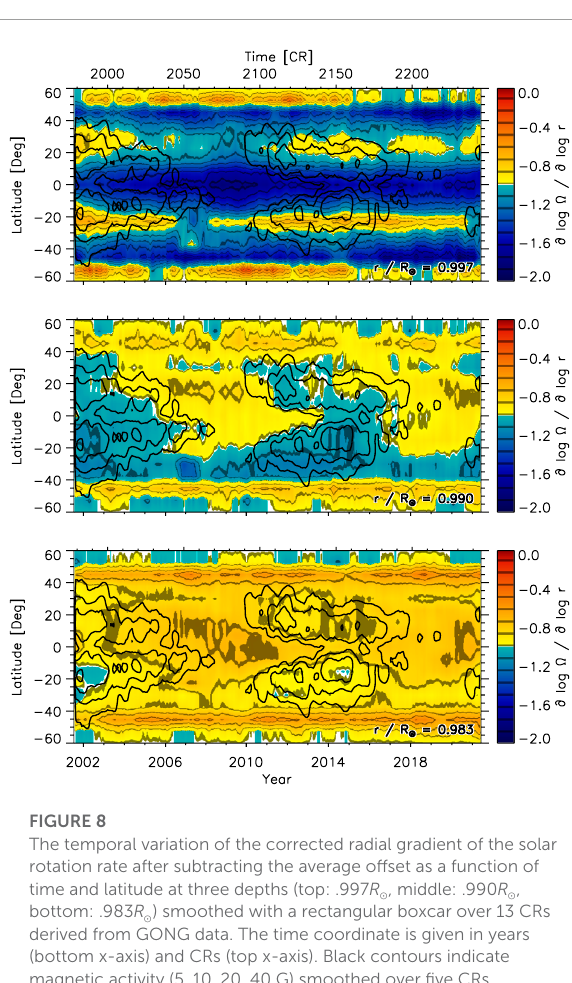
FIGURE 8 The temporal variation of the corrected radial gradient of the solar rotation rate after subtracting the average offset as a function of time and latitude at three depths (top: .997 R ⊙ , middle: .990 R ⊙ , bottom: .983 R ⊙ ) smoothed with a rectangular boxcar over 13 CRs derived from GONG data. The time coordinate is given in years (bottom x-axis) and CRs (top x-axis). Black contours indicate magnetic activity (5, 10, 20, 40 G) smoothed over five CRs. Compare with Figure 6 .